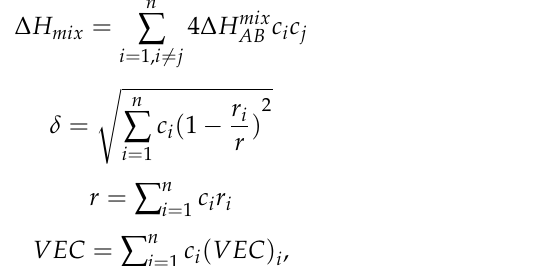
Table 5. The mixing enthalpy of atomic pairs and physiochemical parameters of constituent elements. Enthalpy of Mixing (KJ/mol) Elements Al Cr Fe